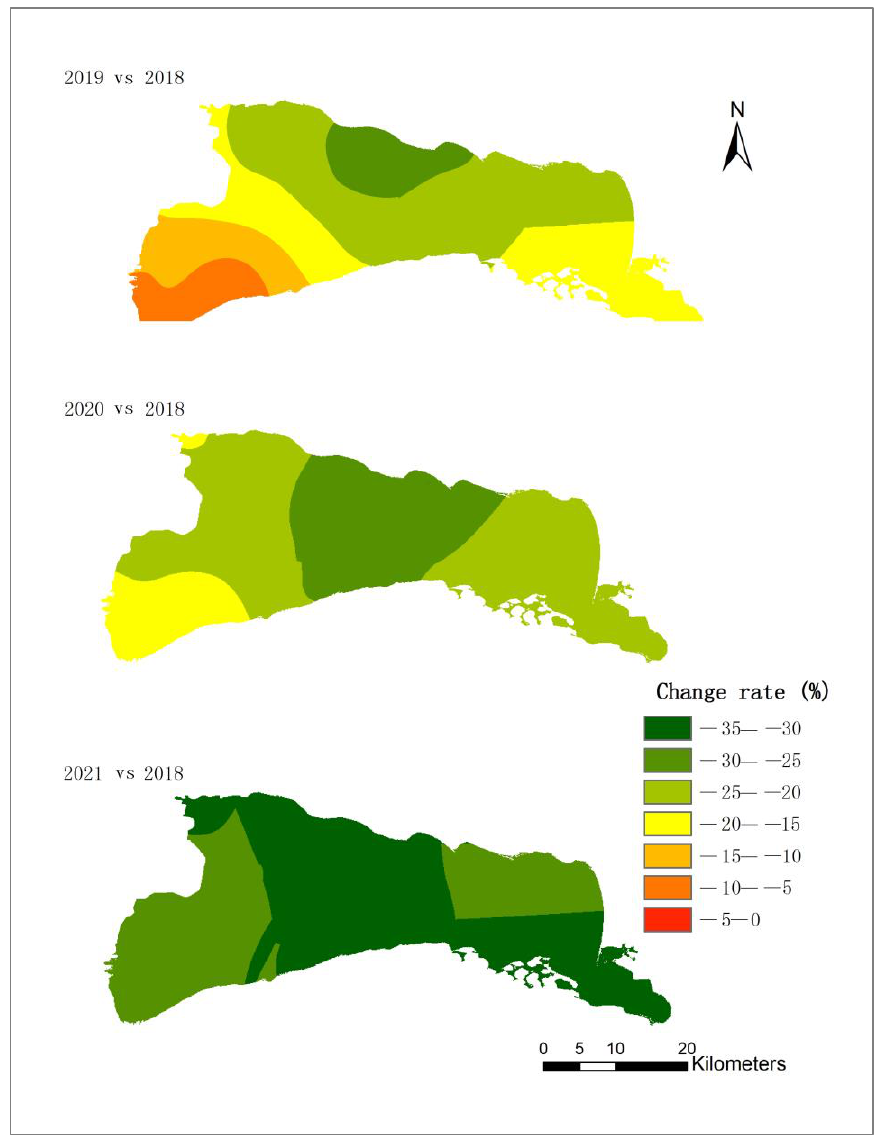
Figure 10. Improvement rate of TDS content in Bosten Lake in 2019, 2020, and 2021, compared to prior to the water diversion implementation (2018).